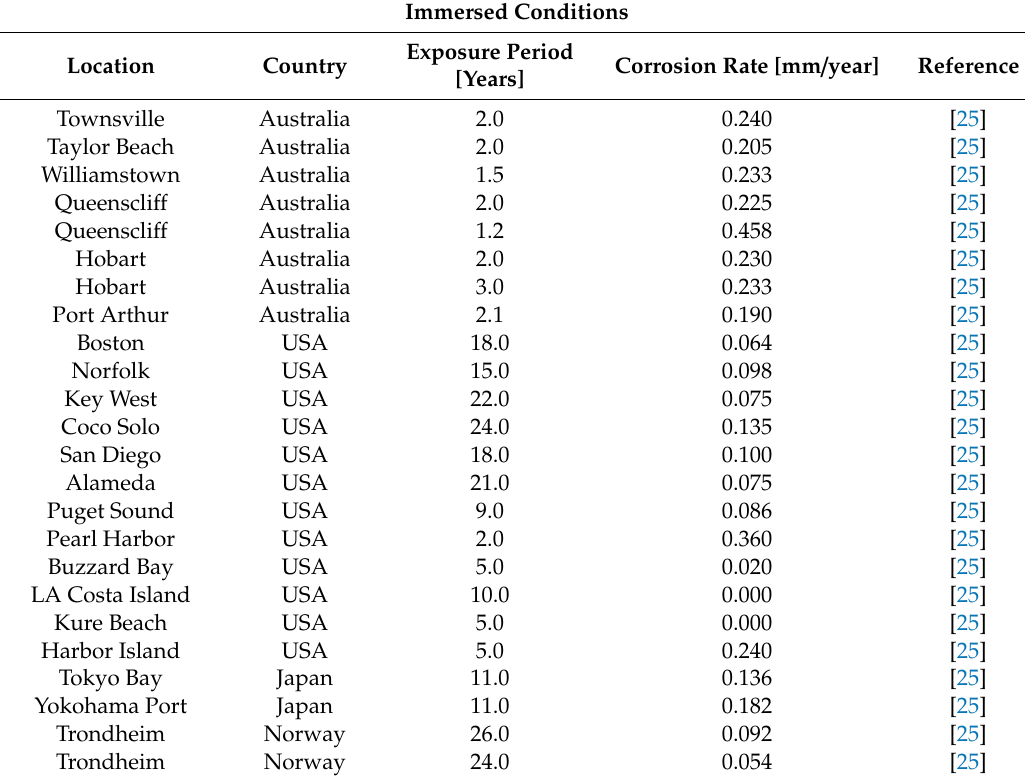
Table 4. Corrosion rates from other